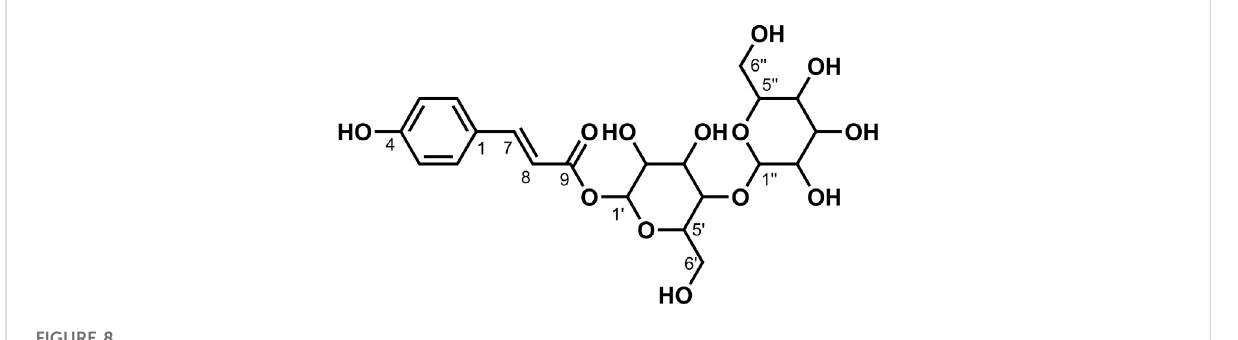
FIGURE 8 Chemical structure of compound 12 .